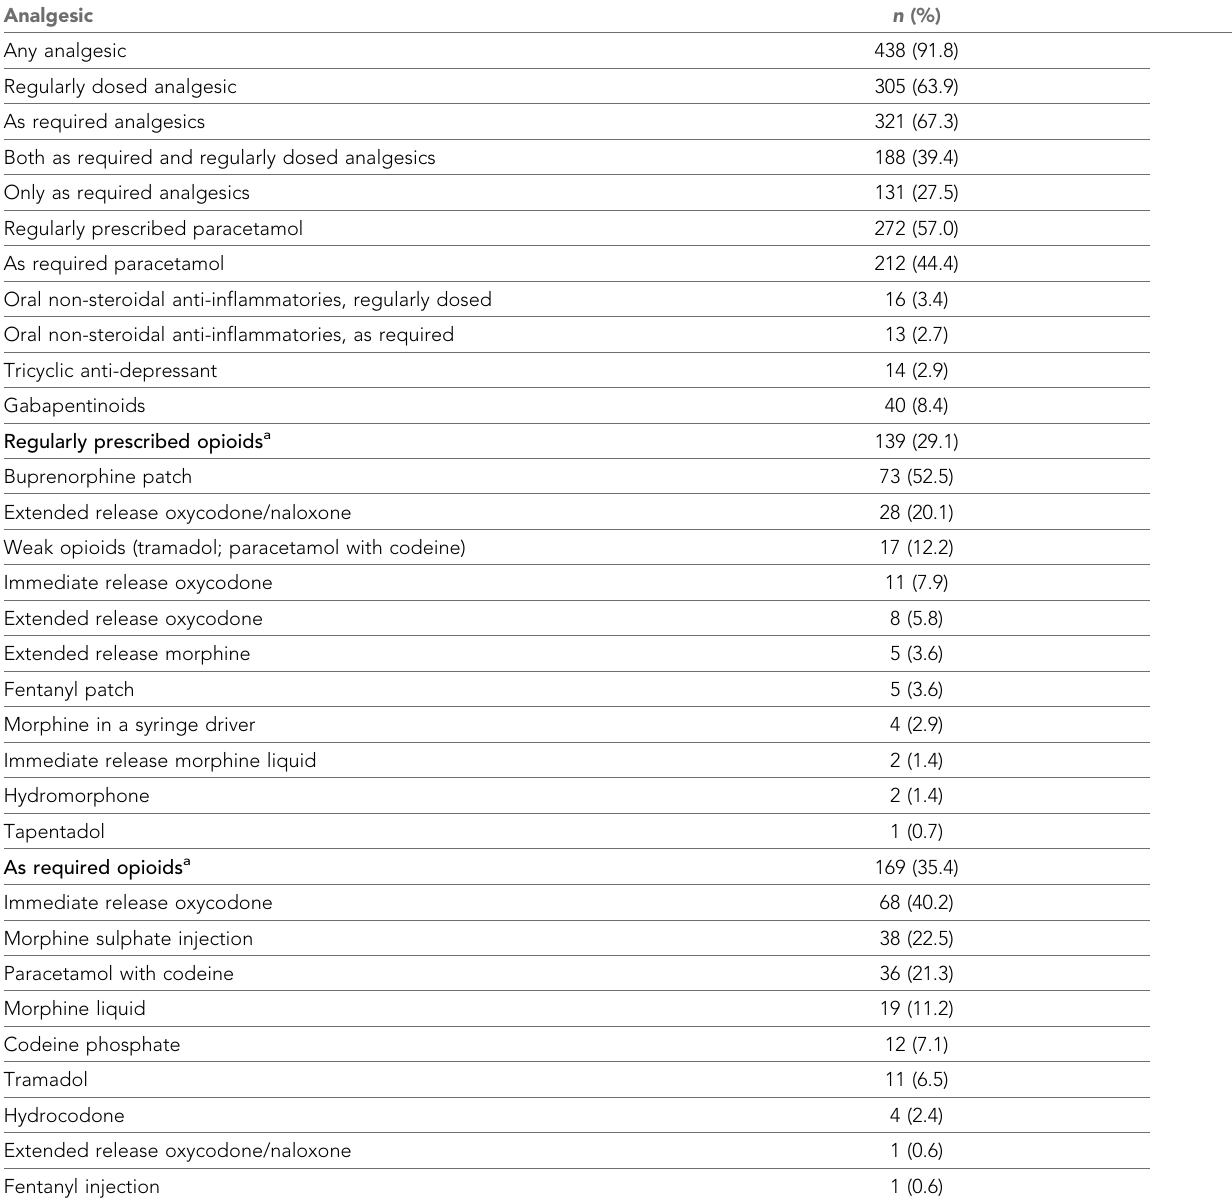
Table 1. Pain management strategies prescribed to the ACF population ( n = 477)